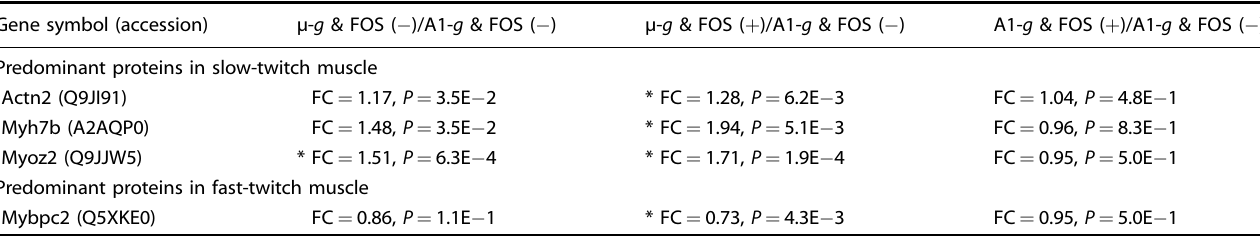
Table 7. Responses of extensor digitorum longus (EDL) muscle proteins composing sarcomere and affecting muscle contractile properties to microgravity (µ- g ) or arti fi cial 1- g (A1- g ) exposure and/or fructo-oligosaccharide (FOS) ingestion.